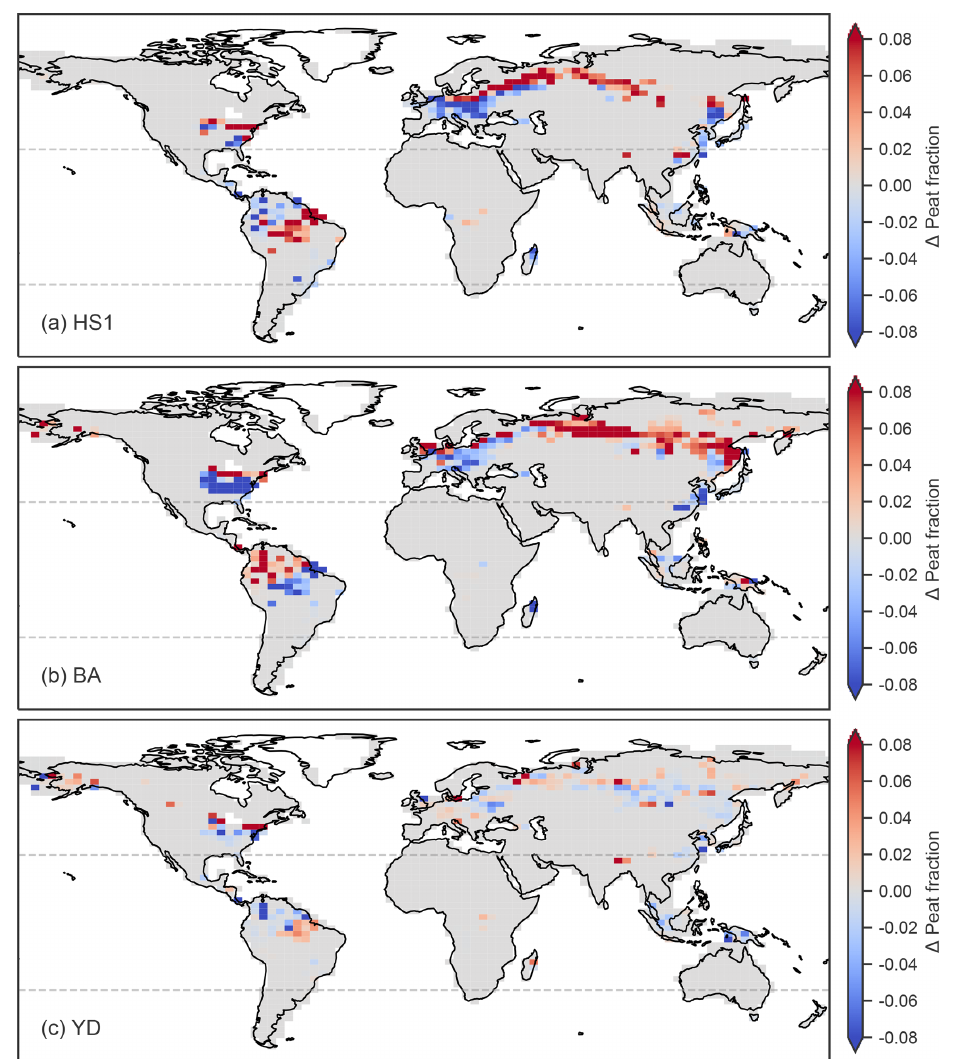
Figure 5. Maps showing the changes in the peatland fraction during three periods of past substantial climate change: (a) the Heinrich Stadial 1 (HS1, 17.43–14.63kyrBP), (b) the Bølling–Allerød Northern Hemisphere warm period (BA, 14.63–12.85kyrBP), and (c) the Younger Dryas Northern Hemisphere cold period (YD,